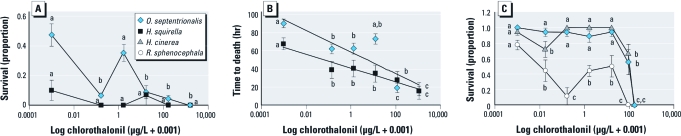
Survival of tadpoles in laboratory experiments I and II. Survival (A) and time to death (B) of O. septentrionalis (15 tadpoles/tank) and H. squirella (5 tadpoles/tank) exposed to several concentrations of chlorothalonil (0.164, 1.64, 16.4, 164, and 1,640 μg/L) and controls (water and solvent combined) for laboratory experiment I (n = 3 for all chlorothalonil concentrations; n = 6 for controls). (C) Survival of O. septentrionalis, H. cinerea, and R. sphenocephala exposed to several concentrations of chlorothalonil (0.0164, 0.164, 1.64, 16.4, 82.0, and 164 μg/L) and control treatments (water and solvent combined) for laboratory experiment II (n = 6 for all chlorothalonil concentrations: n = 12 for controls). Values shown are mean ± SE. Different lowercase letters indicate that responses for a given species were significantly different (p < 0.05) among treatment levels according to Fisher’s LSD multiple comparison tests.